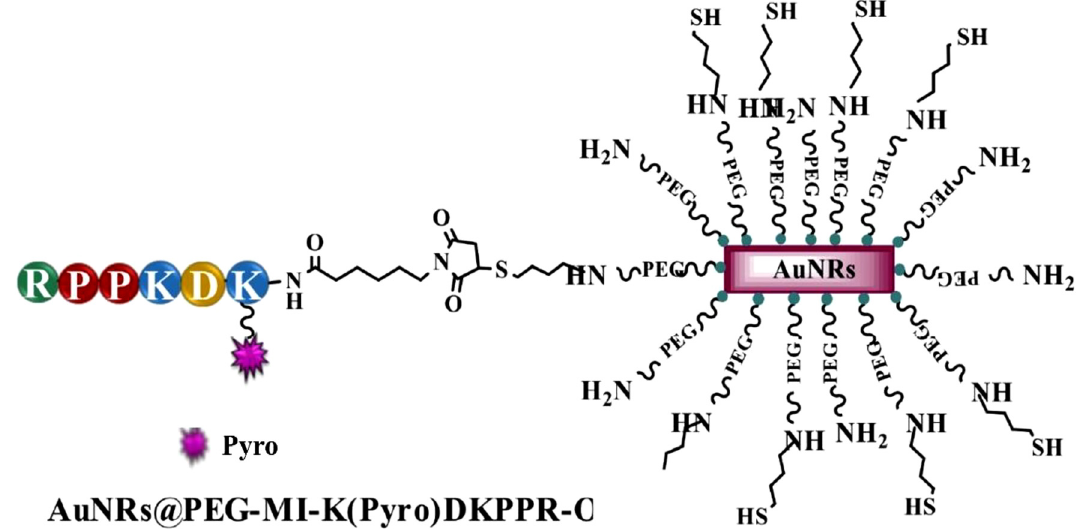
Figure 3: Schematization of AuNRs@PEG-MI-K(Pyro)DKPPR. Adapted from Youssef et al. [24].